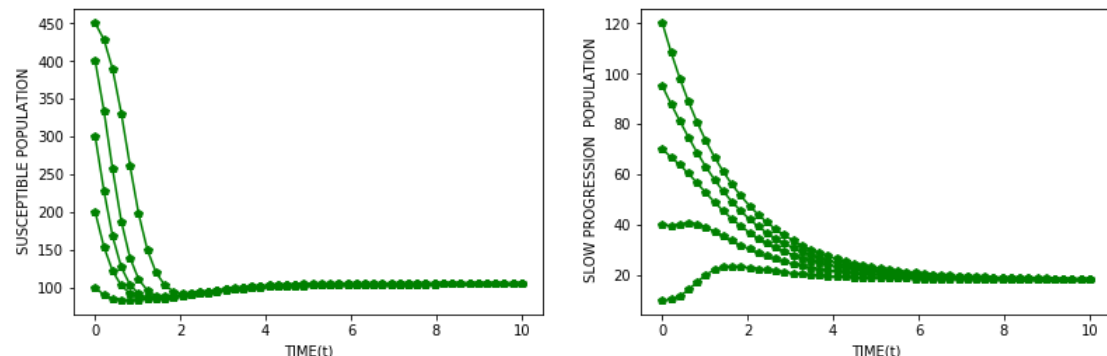
Fig. 8 and Fig. 9 Showing The Behavior of Both Susceptible and Slow Progression Populations when R T is Greater Than Unity.